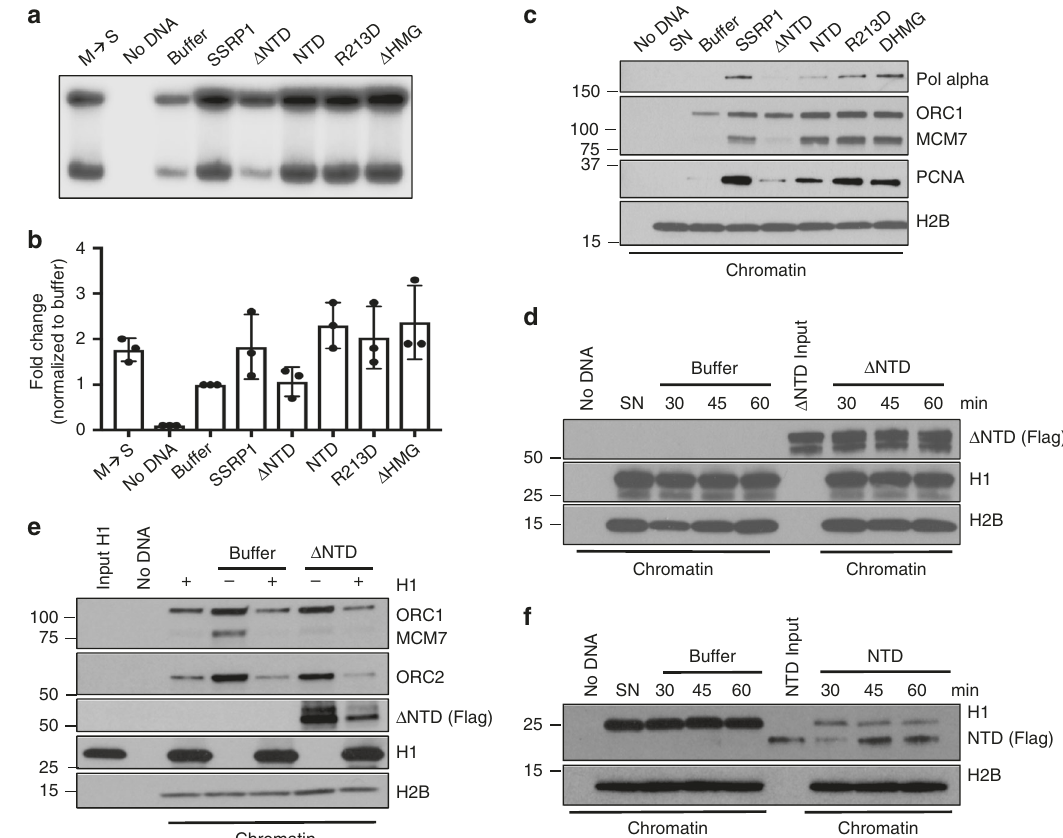
Fig. 5 SSRP1 N-Terminal domain dependent stimulation of DNA replication through histone H1 chromatin eviction. a Representative autoradiography of a DNA replication assay showing α - 32 P-dCTP incorporation for 120 min in SN pre-incubated with 200 ng/ μ l recombinant SSRP1 or equimolar amounts of its mutated versions, as indicated. b Graph indicating fold change in somatic DNA replication ef fi ciency relative to buffer considered as 1. SN were pre- incubated with 200 ng/ μ l recombinant SSRP1 or equimolar amounts of its mutated versions as indicated. Bars represent mean ± SEM. n = 3 independent experiments; p < 0.005 when comparing all values. Two-way anova. c WB of chromatin isolated at 60 min after addition to interphase egg extracts of